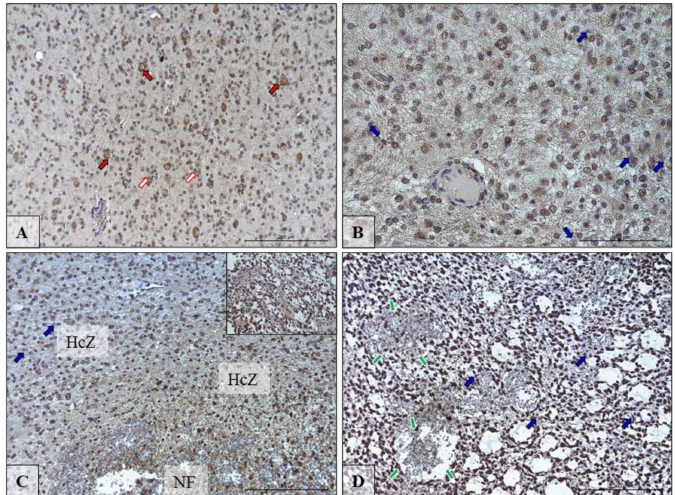
Figure 4. Representative microphotographs showing the protein expression of desaturase SCD in neurons and glia cells in the peritumoral area ( A ; red and white arrows) and in cells in the growing tumor area ( B ; blue arrows) necrotic core ( C , D ; blue arrows) of brain tumors from patients diagnosed with glioblastoma. Please note that on microphotography of GTA / NC, there are many pathologically changed regions of the brain tissue that indicate brain cell necrosis envelope by hypercellular zones (HcZ), with additional microvascular hyperplasia (green arrows). There are microphotographs